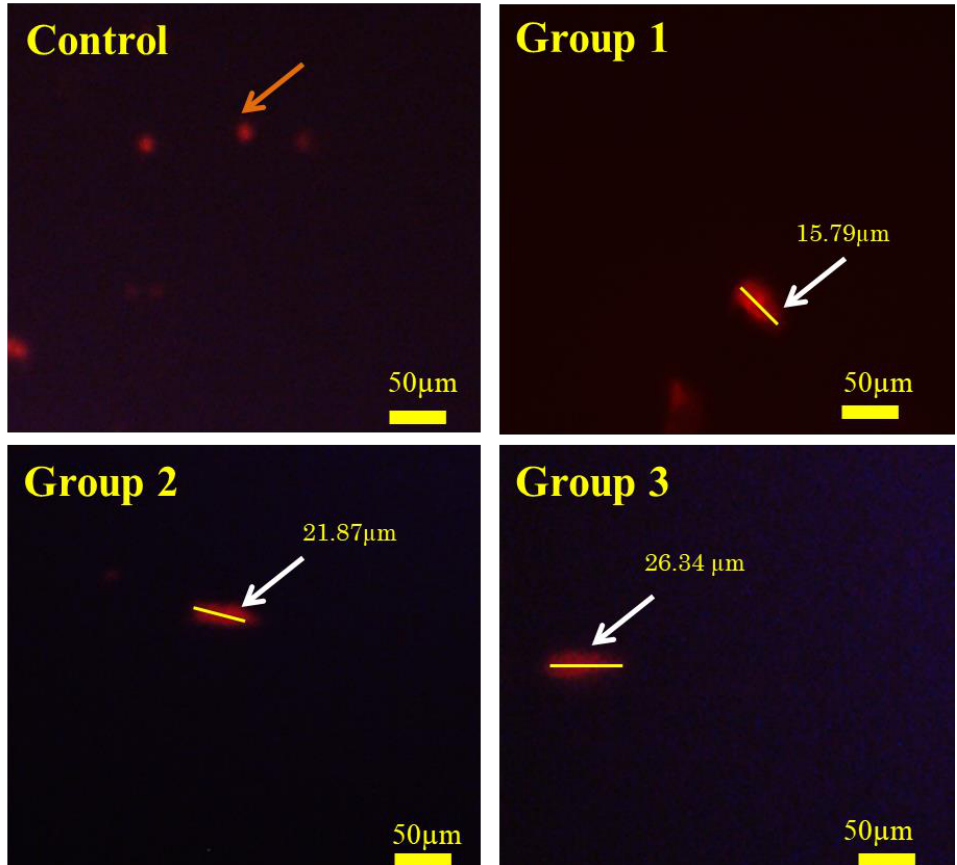
Figure 7. Fluorescent images of comet assay in Oreochromis mossambicus liver tissue of 14 days polypropylene microplastics treated groups [100 mg/kg (Group 1), 500 mg/kg (Group 2), 1000 mg/kg (Group 3)] showing the increasing degree of DNA damage (magnification: 20 × ) and the arrow indicates the DNA damages (Orange arrow-Oval-shaped; white arrow-comet-shaped) of liver cells.